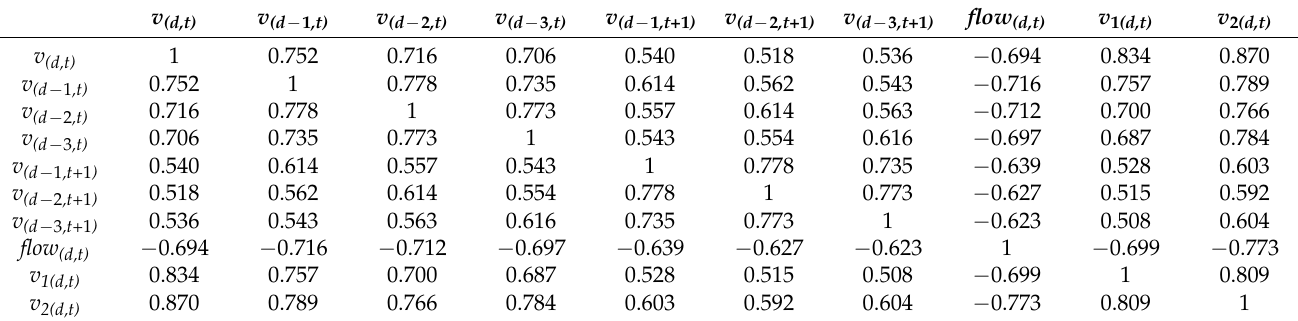
Table 3. Pearson correlation coefficients for southbound traffic on Xingzhong